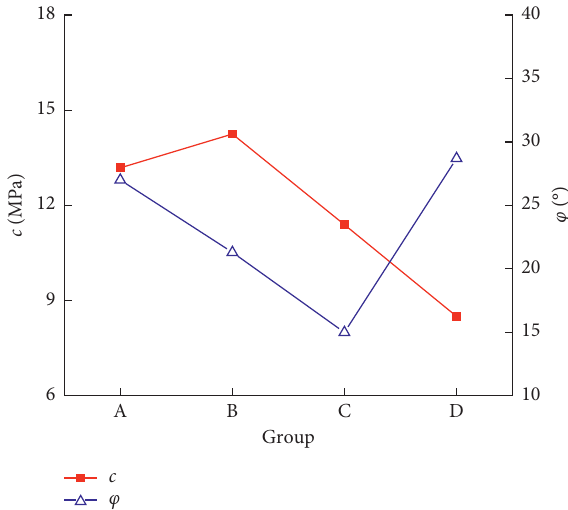
Figure 9: Relationship between cohesion, internal friction angle, and water content of each group of